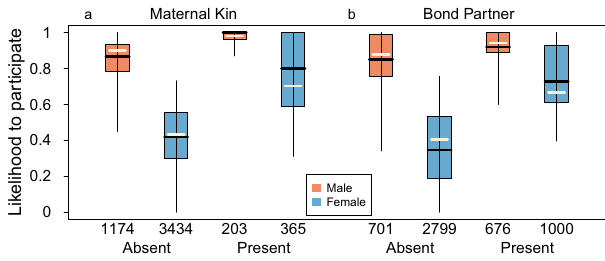
Fig. 2 Does predictability of reciprocity in fl uence participation? The effect of the presence of a adult maternal kin or b social bond partner on the likelihood to participate in intergroup encounters in males (orange, 36 individuals) and females (blue, 75 individuals). The black horizontal lines represent medians, the boxes represent quartiles, the vertical lines represent the 5th and 95th precentiles, and the white horizontal line represent the fi tted model. Source data are provided as a Source Data fi le.